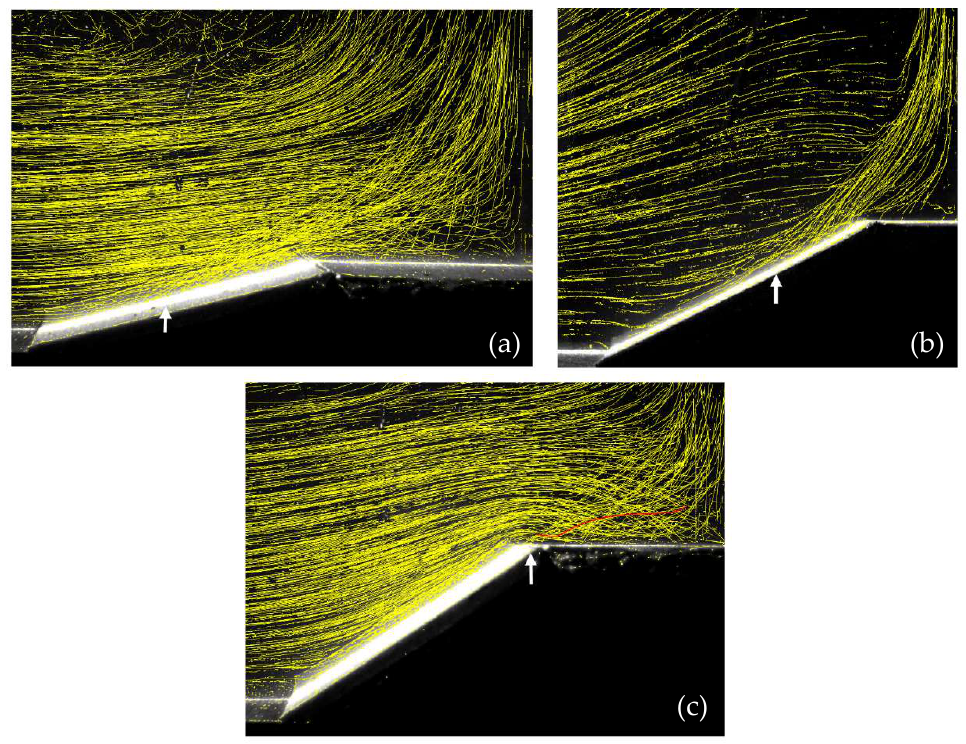
𝐿 (cid:2868) , ( b ) 𝛽 = L 0 , ( b ) β = 25 ◦ (cid:2872) 4